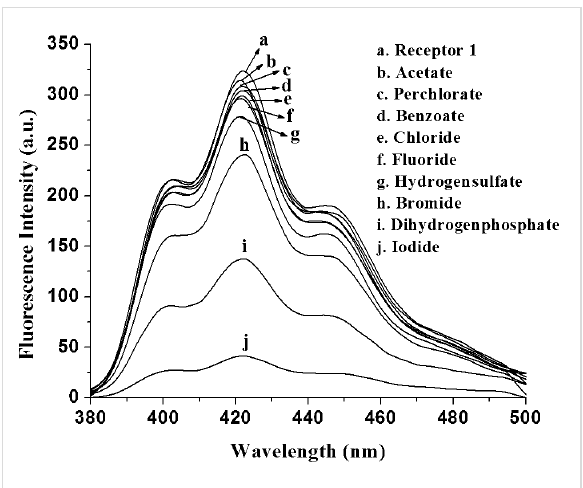
Figure 11: Change in fluorescence emission of 1 ( c = 5.78 × 10 − 5 M) in the presence of 2 equiv of tetrabutylammonium salts of different guests in CHCl 3 containing 0.1% CH 3 CN.